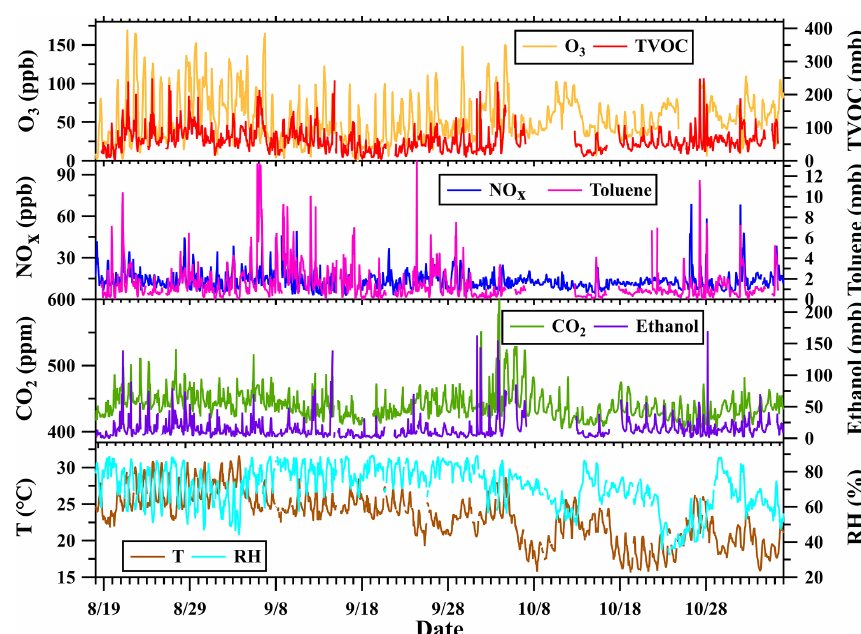
Figure 1. Time series of concentrations of some typical chemical species along with meteorological parameters (hourly averages) during the CTT campaign. Temperature ( T ), relative humidity (RH), and concentrations of ozone and NO x were measured at 488m. Concentrations of VOCs, ethanol, and CO 2 were measured at